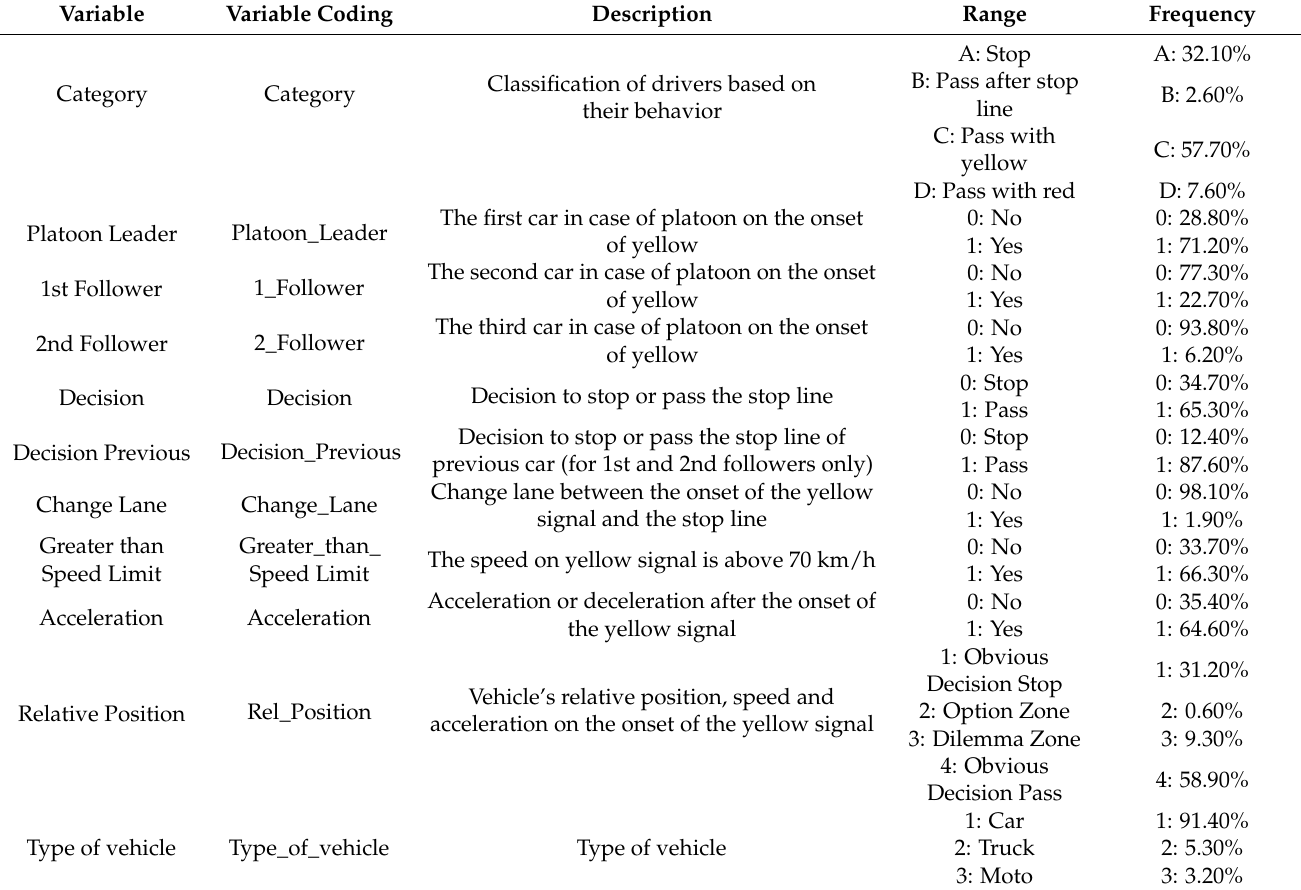
Table A2. Descriptive statistics of main nominal